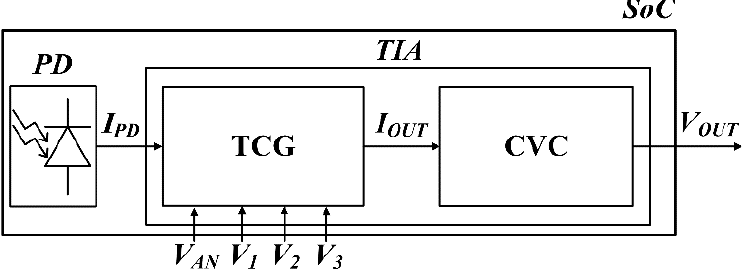
Figure 1. Overall block scheme of the developed CMOS integrated optoelectronic sensing SoC. TCG and CVC are the tunable current gain and the current to voltage conversion stages.